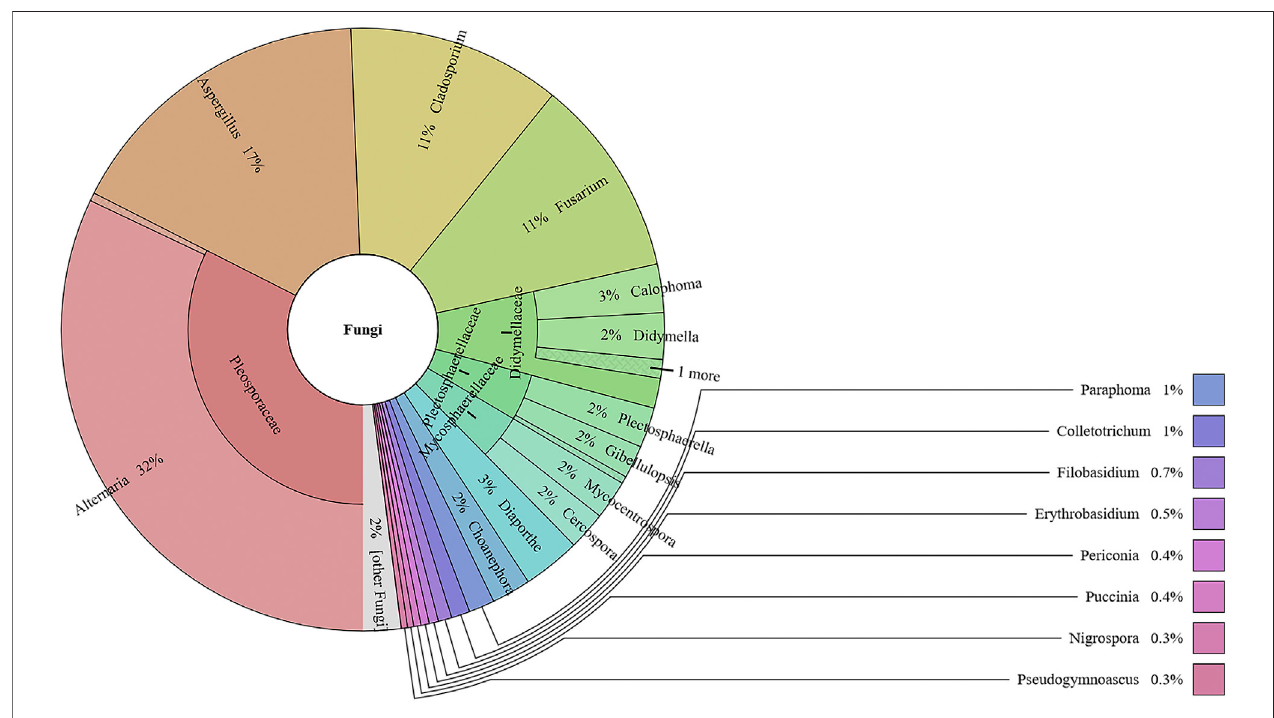
FIGURE 3 | The fungal composition detected in lab-made mock and commercial FKDSW samples at the family and genus levels.